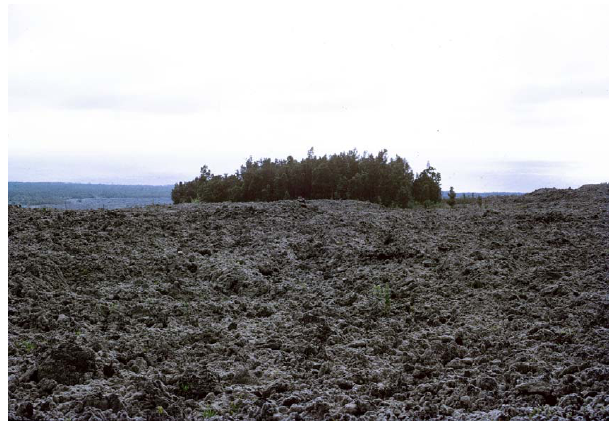
Fig. 1. The 1955 Kam ā `ili `a` ā flow with kipuka in background (photo by D. Mueller-Dombois, 1971).